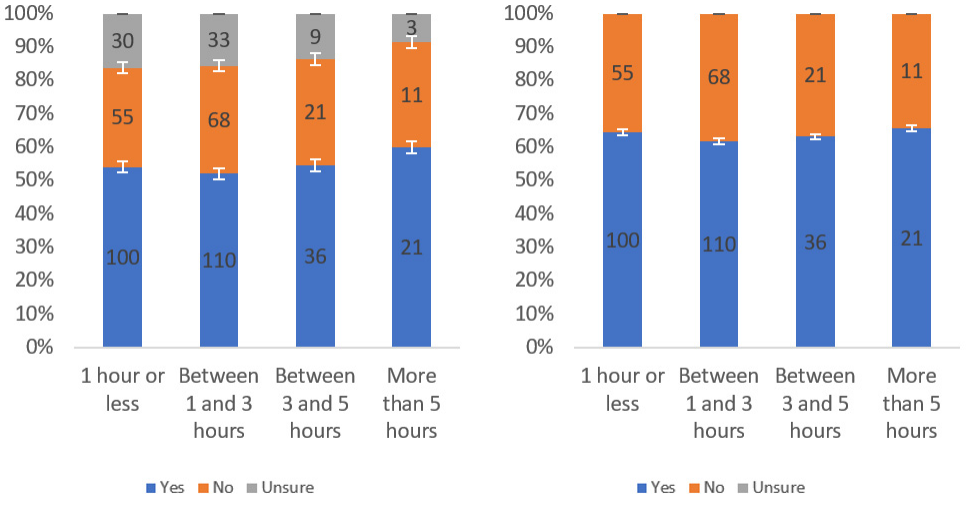
Figure 53. Responses regarding usefulness in judging trustworthiness by internet usage level including ( left ) and excluding ( right ) unsure responses.